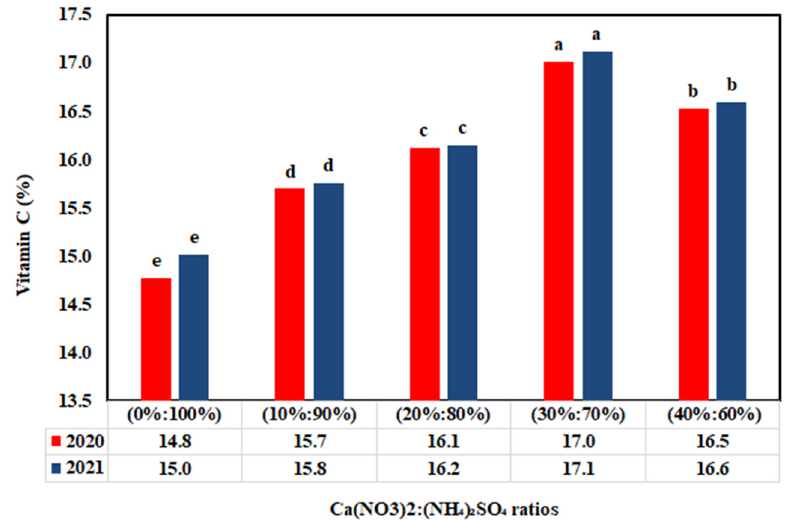
Figure 2. The impact of Ca(NO 3 ) 2 :(NH 4 ) 2 SO 4 ratios on vitamin C of the pomegranate fruits of cv. ‘Wonderful’ in 2020 and 2021 seasons. Significant differences ( p < 0.05) are denoted by values in the same column that are marked with distinct letters.